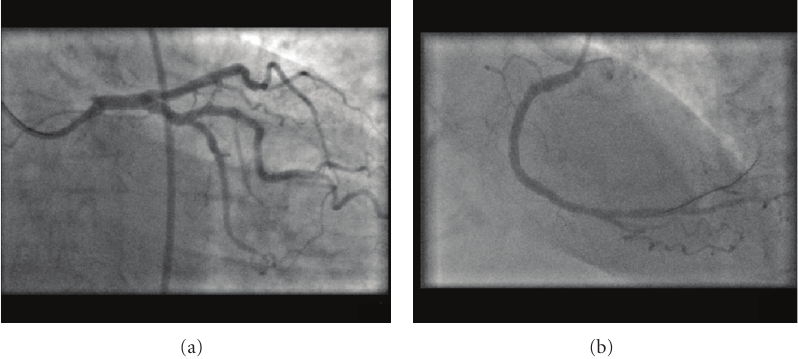
Figure 3: Double-inversion technique. Panel (a): LAO caudal view (as in Figure 2(a)) with additional horizontal inversion demonstrating apparent “normal” RAO caudal angiographic appearances. Note, also, engagement of the EBU catheter. Panel (b): RAO view of the left-sided right coronary artery with additional horizontal inversion mimicking a conventional LAO